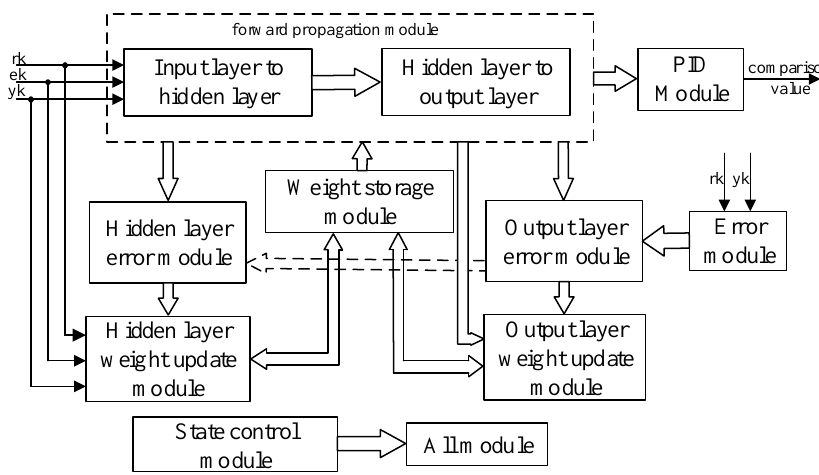
Figure 4. FPGA design framework of BP neural network PID